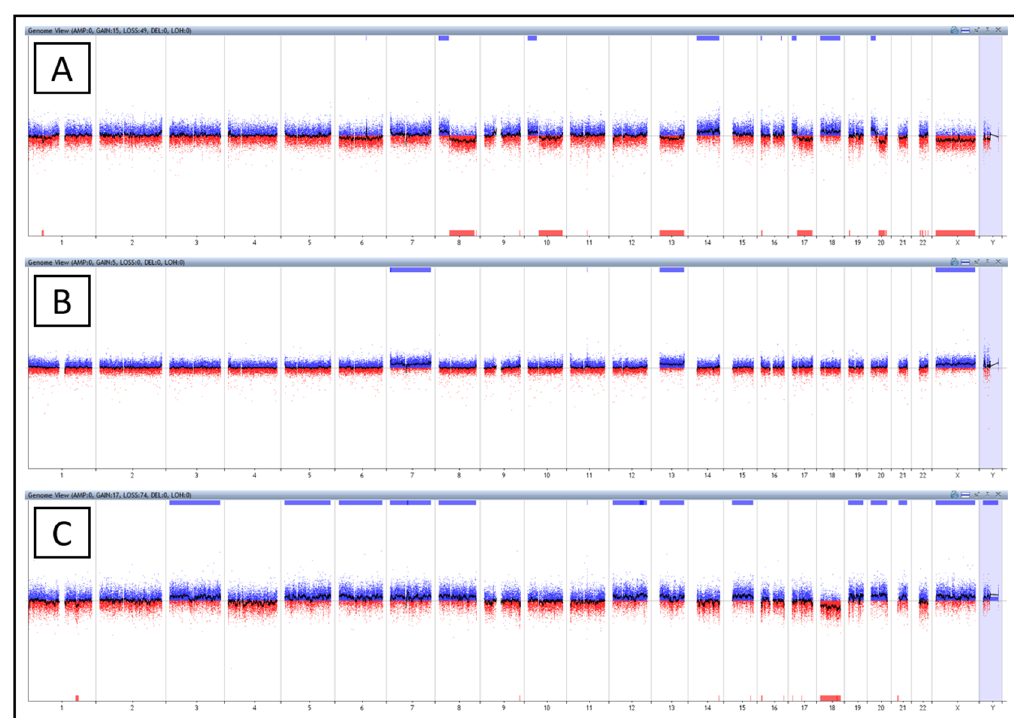
Figure 2. The entire genome of patient P4 ( A ), P5 ( B ), P16 ( C ). ( A ) Trisomy of chromosomes 14 and 18, monosomy of chromosomes 13 and X, aberrations on chromosomes 1, 6, 8, 10, 11, 17, 20 at P4. ( B ) Trisomy of chromosomes 7, 13, X and aberration on chromosome 11 at P5. ( C ) Trisomy of chro- mosomes 3, 5, 6, 7, 8, 12, 13, 15, 19, 20, 21, X, Y, monosomy of chromosome 18, and aberration on chromosome 11 at